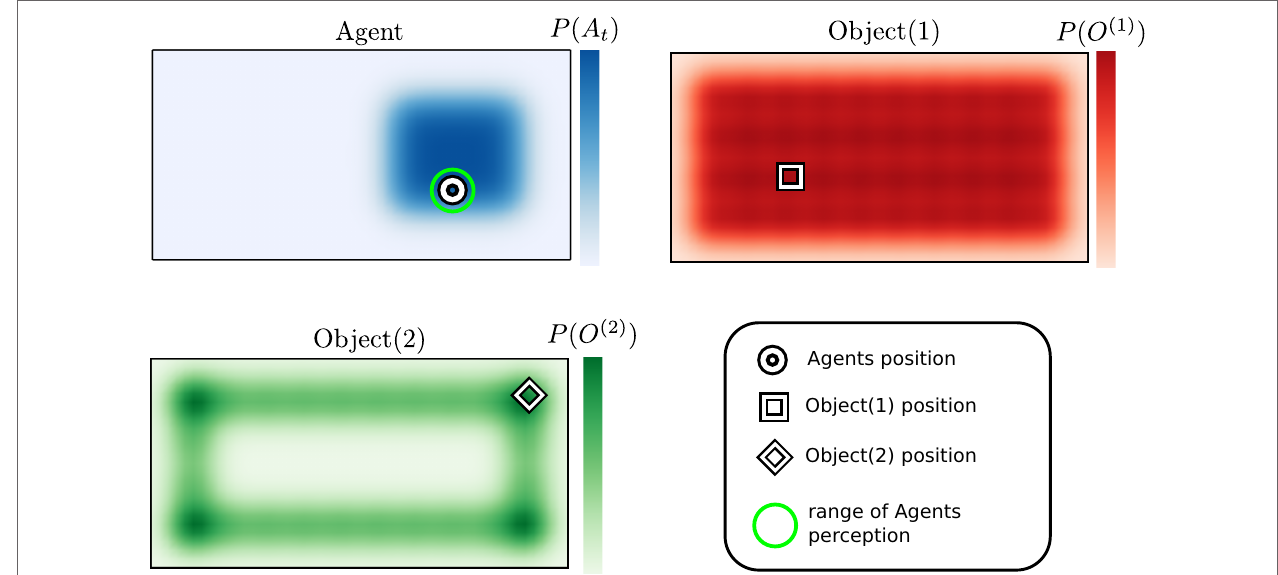
FIGURE 1 | Rectangle world. There are three different probability density functions present. The blue represents the believed location of the agent, the red and green probability distributions are associated with objects 1 and 2. The white shapes in each figure represent the true location of each associated object or agent.